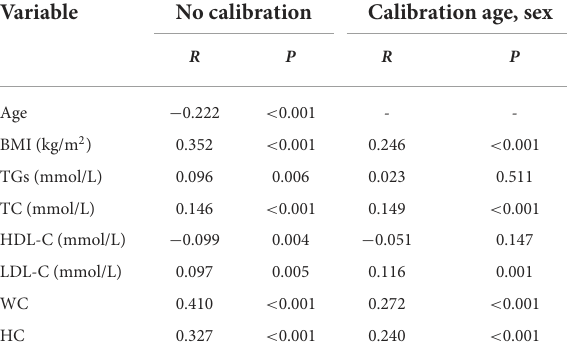
TABLE 3 Correlation coefficients between SUA and all